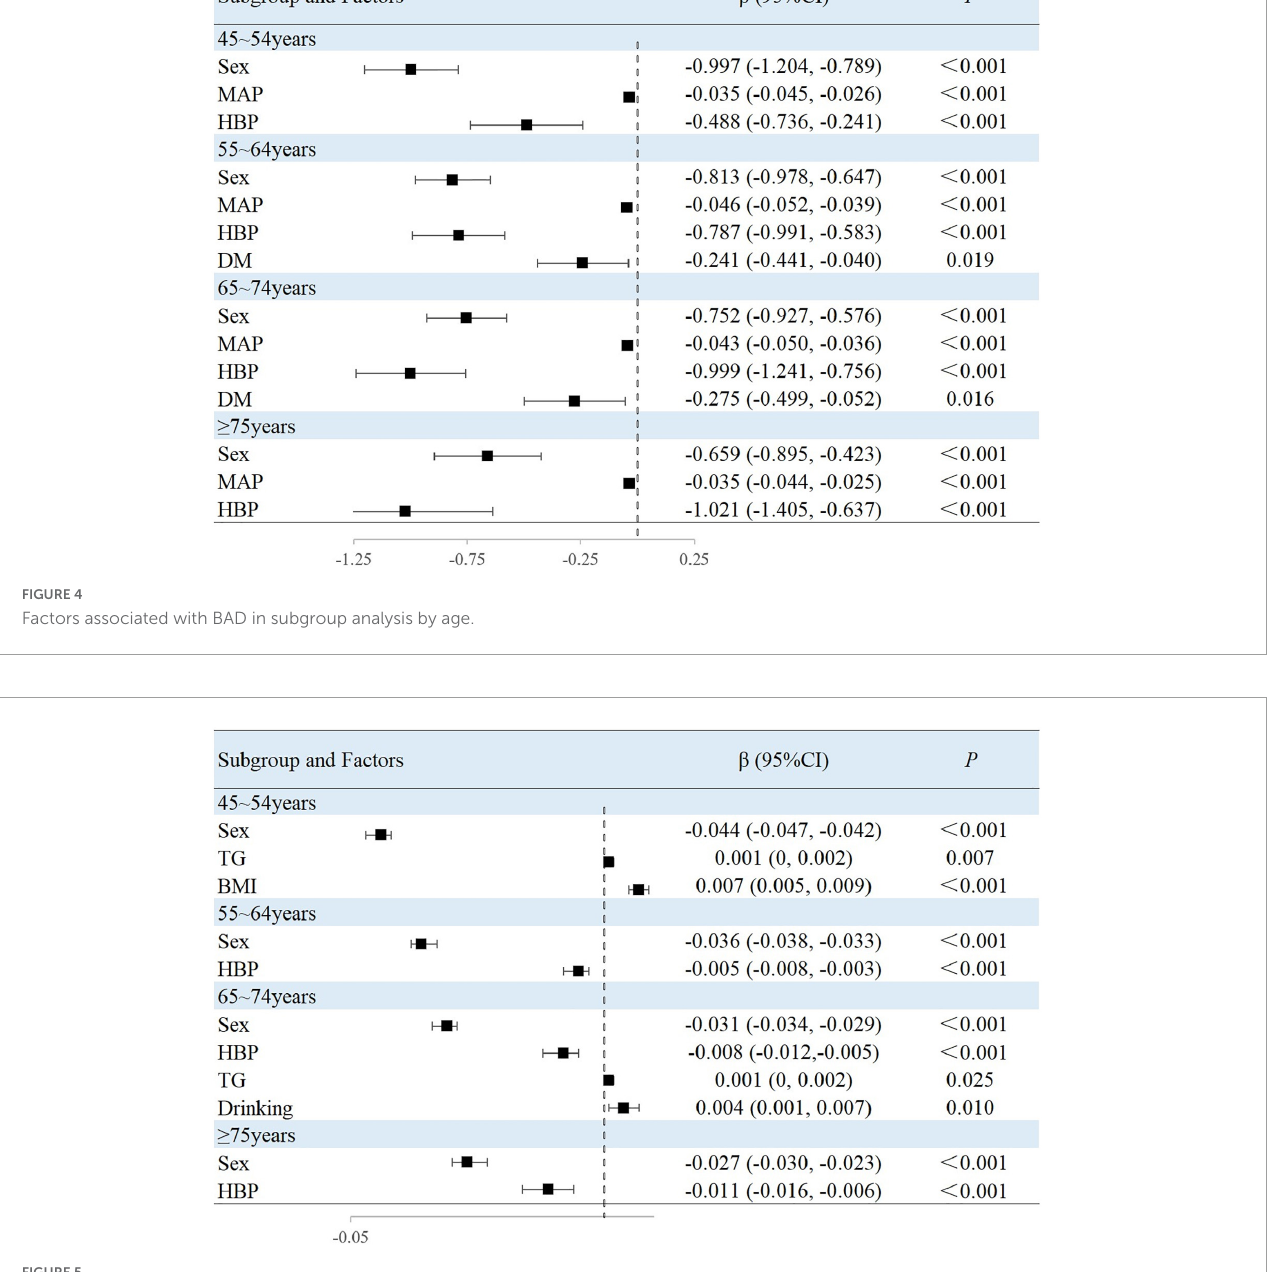
FIGURE5 Factors associated with BAC in subgroup analysis by